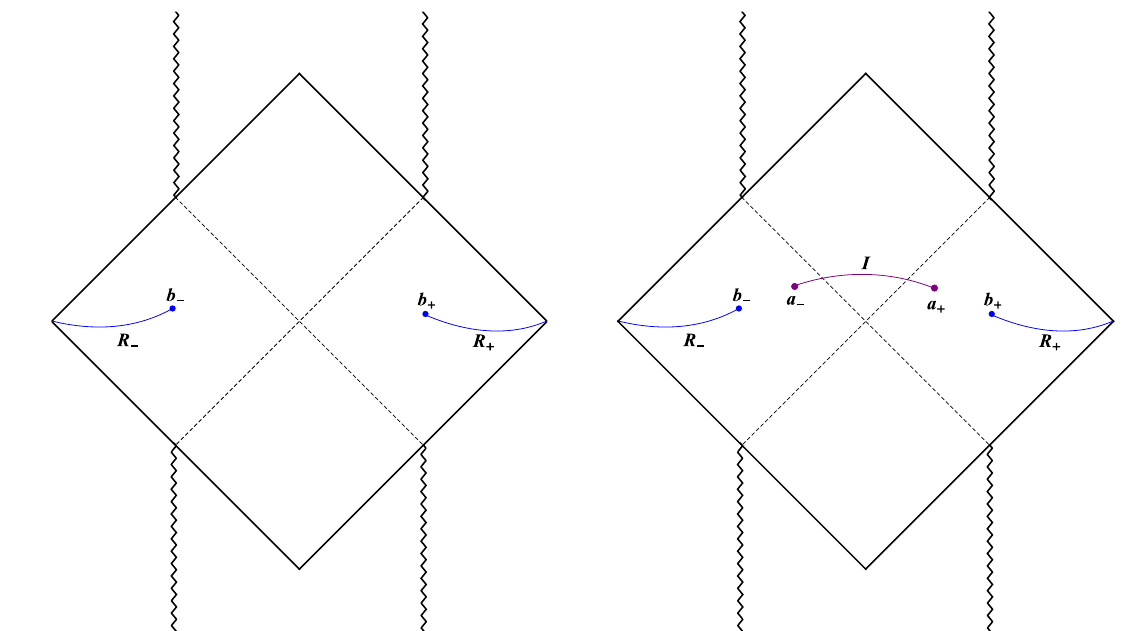
of two parts R ± whose boundaries are denoted by b ± . I refers to the island with the boundaries represented by a